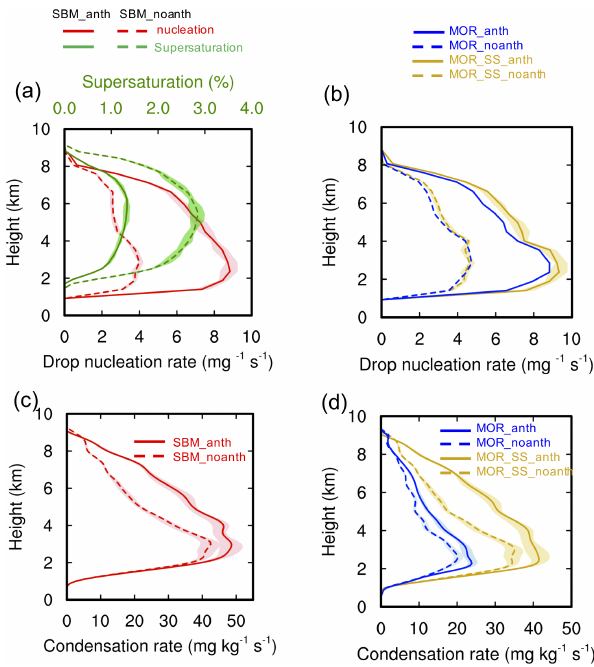
Figure 13. Vertical profiles of (a, b) drop nucleation rate (red; unit: mg − 1 s − 1 ) and supersaturation with respect to water (green; unit: %) from SBM_anth and SBM_noanth; (b) drop nucle- ation rate (unit: mg − 1 s − 1 ) from MOR_anth and MOR_noanth (blue) and from MOR_SS_anth and MOR_ SS_noanth (orange); (c) condensation rate (unit: mgkg − 1 s − 1 ) from SBM_ anth and SBM_noanth (red); and (d) condensation rate (unit: mgkg − 1 s − 1 ) from MOR_anth and MOR_noanth (blue) and from MOR_SS_anth and MOR_SS_noanth (orange). All the values are the mean of the top 25 percentiles (i.e., from the 75th to the 100th percentile) of the updrafts with velocity greater than 2ms − 1 over the study area (red box in Fig. 7) during the strong convection period (20:00– 23:00UTC on 19 June 2013). Data are processed in the same way as for Fig. 11.